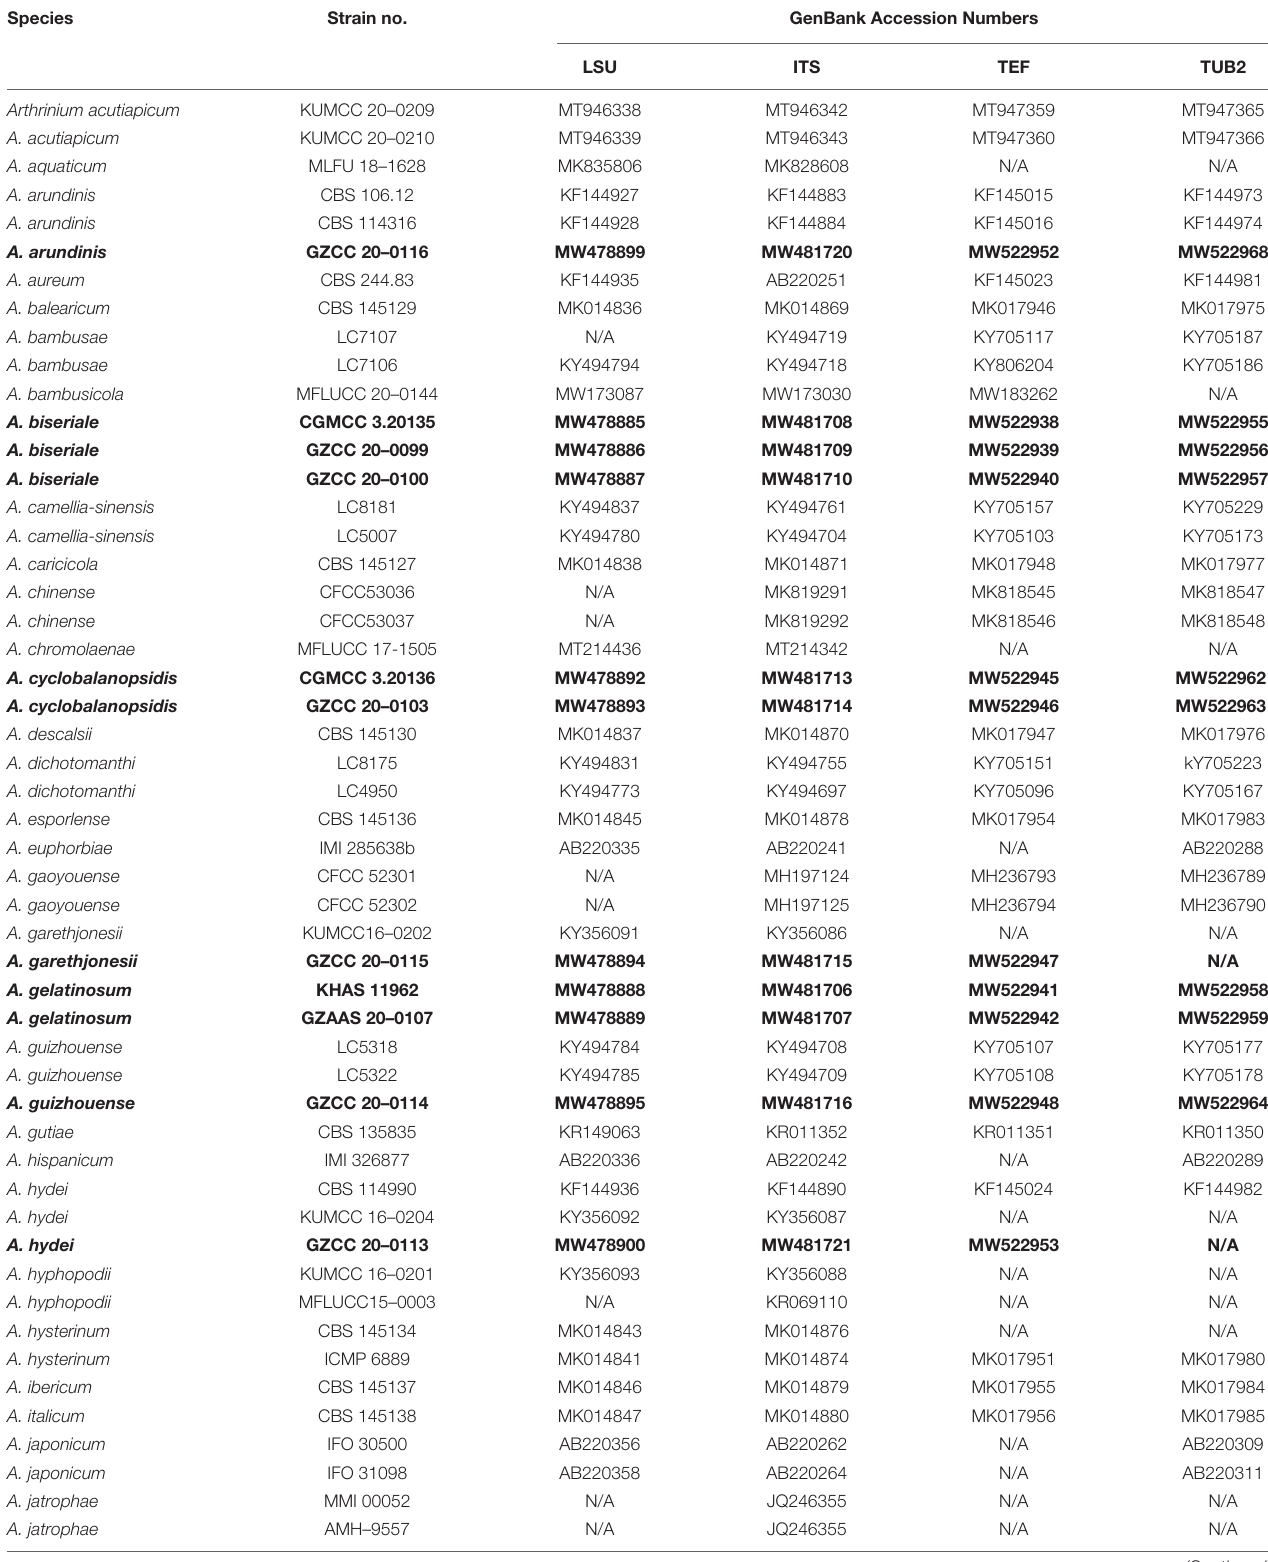
TABLE 1 | GenBank accession numbers of species included in the phylogenetic study. Species Strain